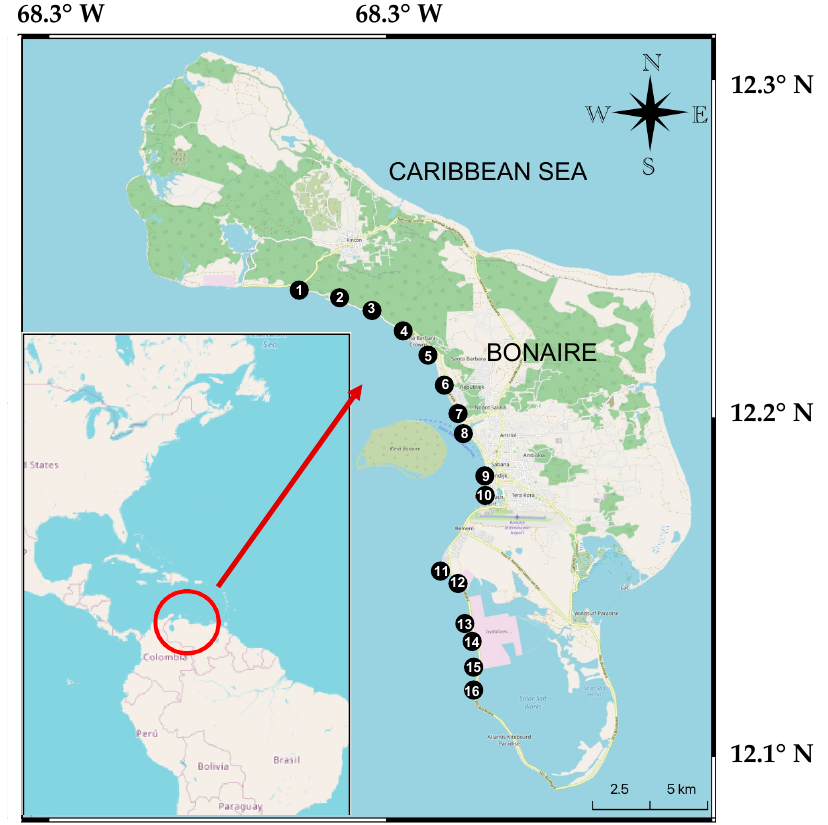
Figure 2. Map of Bonaire, Dutch Caribbean (12°12 ′ N, 68°35 ′ W) highlighting the dive sites investigated for sponges– Nemalecium lighti association in this study. Map made from OpenStreetMap loaded into QGIS.